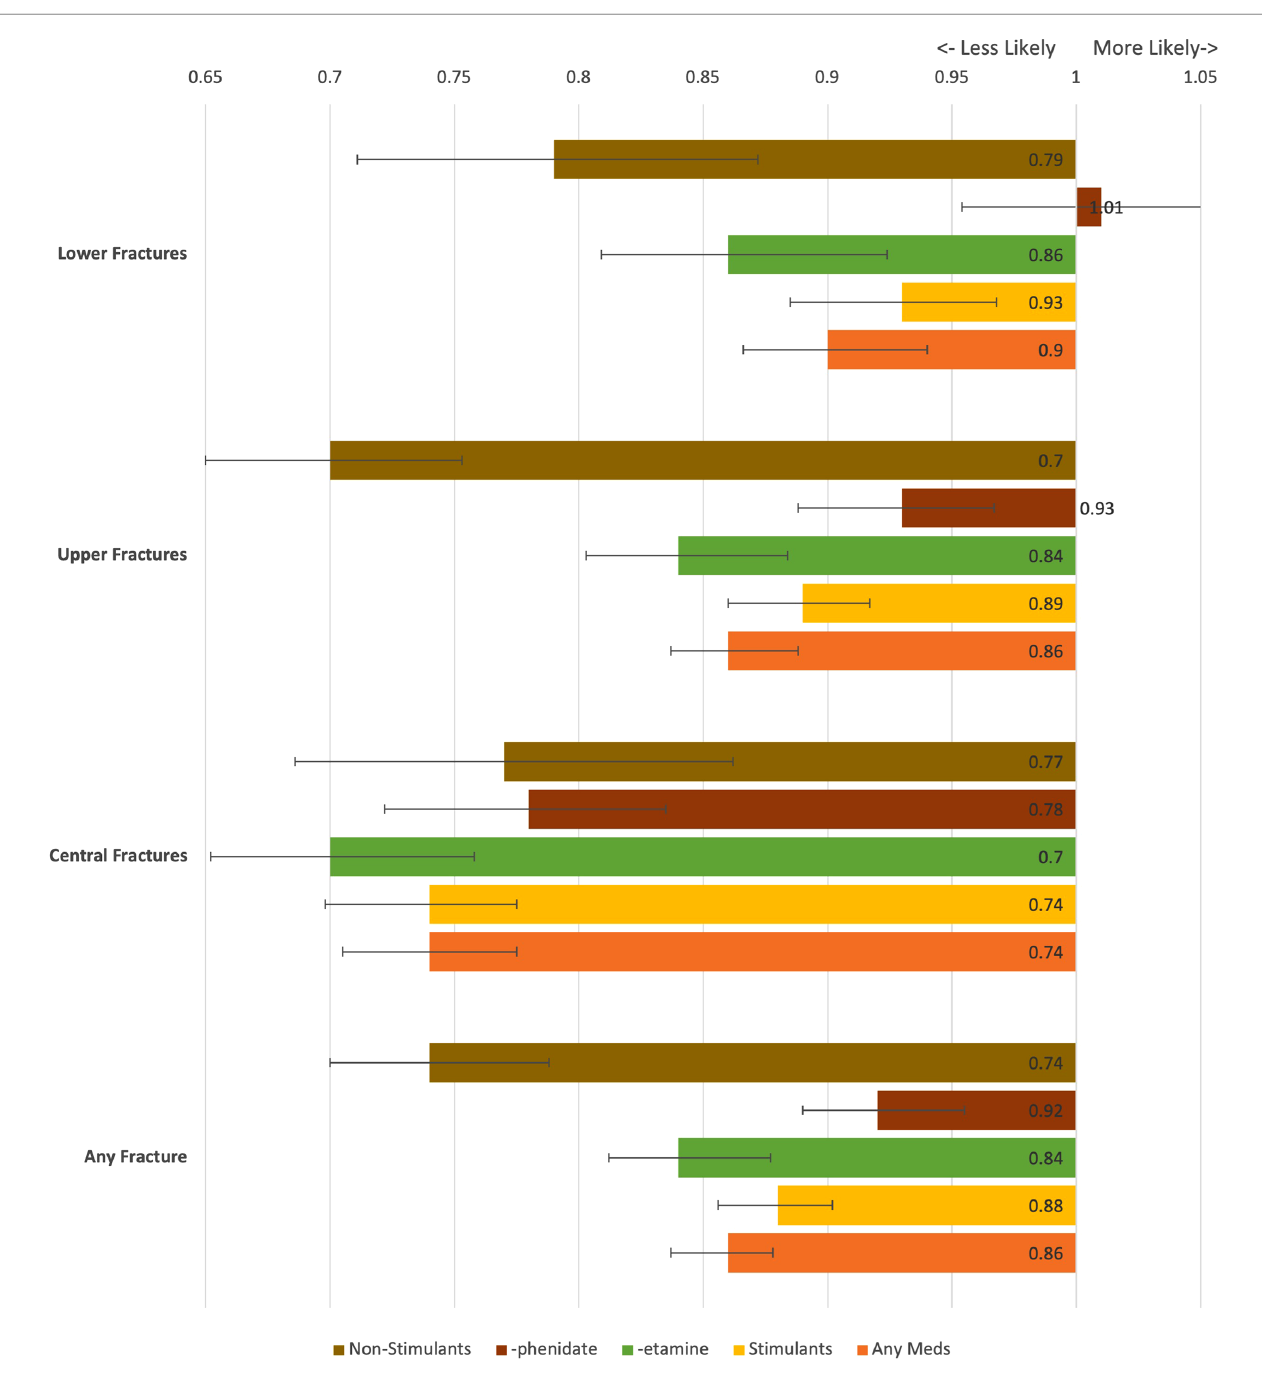
FIGURE 2 Odds ratio for fractures by medication type. Con fi dence bars depict a 95% CI. A value greater than 1 indicates the fracture is more likely in ADHD patients on that medication, while a value under 1 indicates the fracture is less